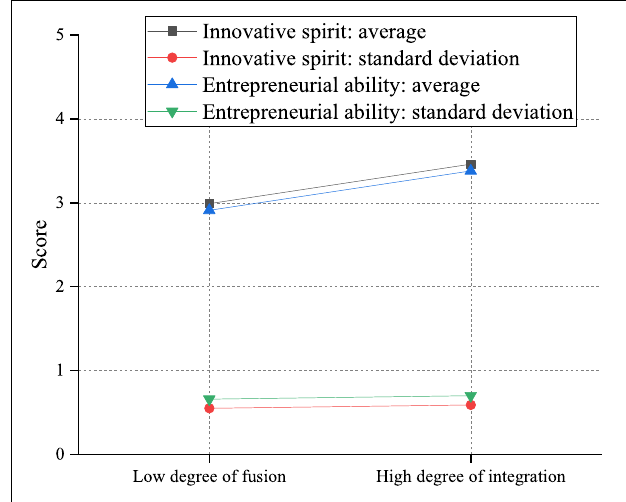
FIGURE 14 | Influence of college students’ perception of innovation and entrepreneurship theoretical courses on their innovation and entrepreneurship ability.